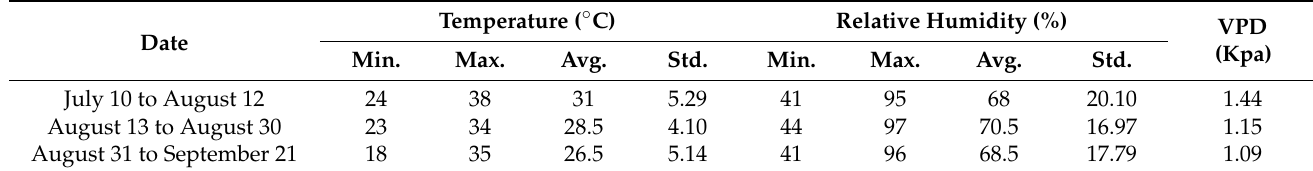
Table 1. Brief measurements of climate factors.